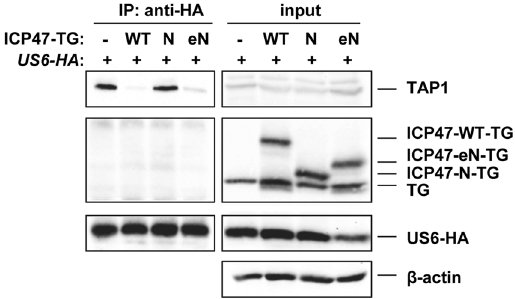
Figure 2. The central part of ICP47 is required to block conformational changes of TAP. HeLa cells stably expressing fusion proteins as indicated were transiently transfected with a US6-HA expression plasmid. At 20 h post-transfection cells were lysed in digitonin lysis buffer and an IP was performed using anti-HA antibodies. Aliquots of the lysates (input) and recovered proteins (IP) were separated by SDS-PAGE and detected in Western blot (TAP1, 148.3; ICP47-TG fusion constructs, anti-TagGFP; US6-HA, anti-HA). One representative experiment out of three independent experiments is